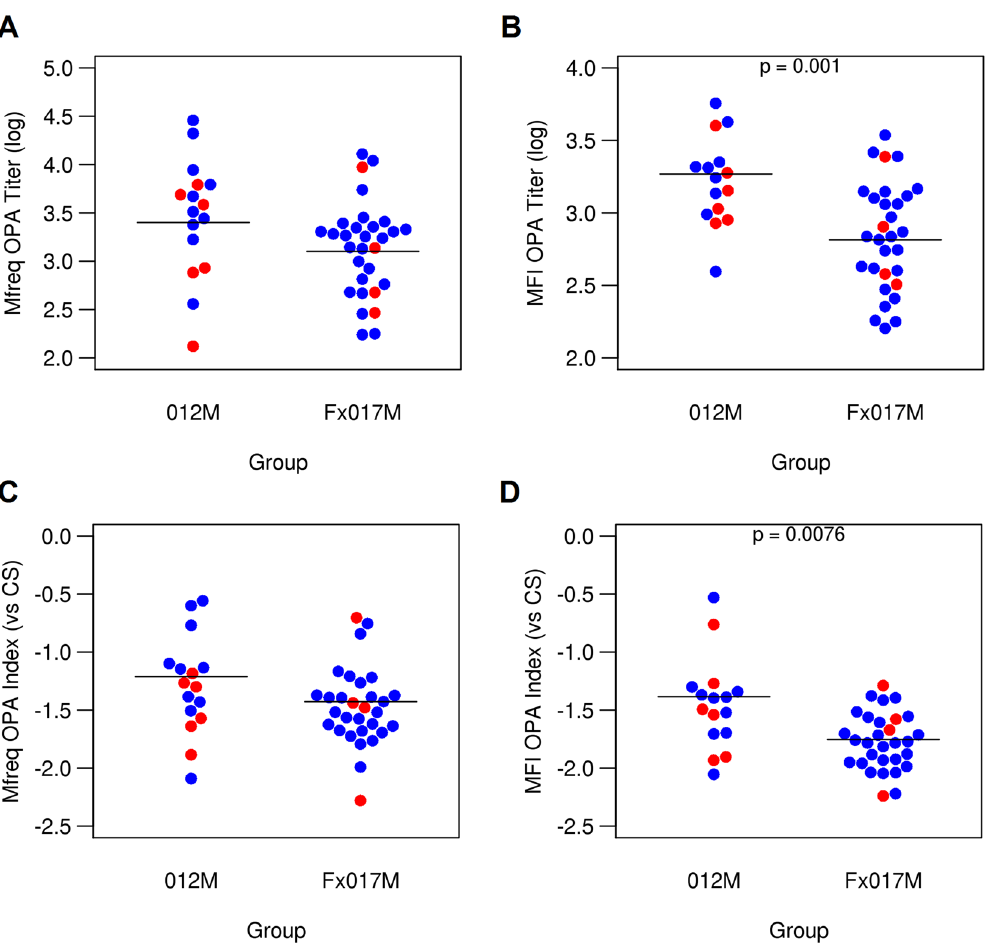
Figure 2. Opsonophagocytic activity in 012M and Fx017M cohorts. OPA titers for Mfreq ( A ) and MFI ( B ) for the 012M and Fx017M cohorts. OPA indices for Mfreq ( C ) and MFI ( D ), relative to CS antibody titer, for 012M and Fx017M cohorts. Protected and non-protected subjects are shown in blue and red,